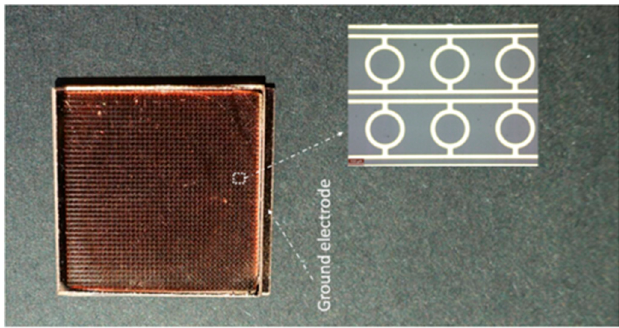
Figure 8. Structure of fabricated metamaterial absorber.